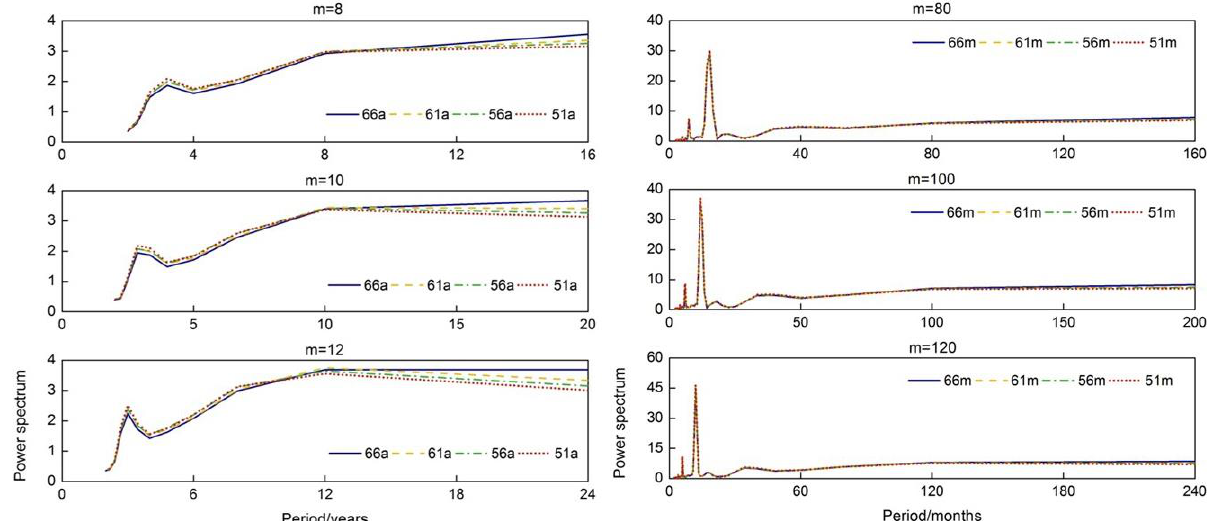
Figure 4. Power spectra of HHS.